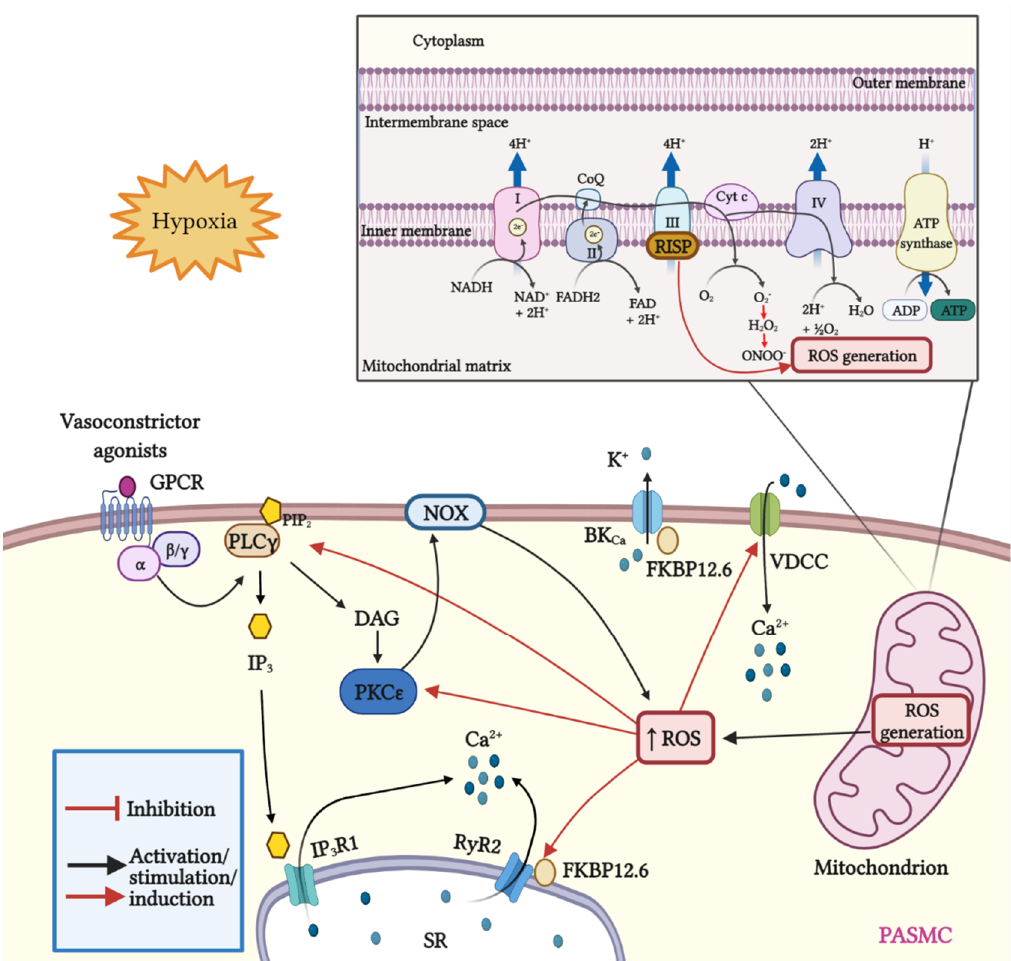
Figure 1. Schematic representation of mitROS generation and signaling; crosstalk between ROS and Ca 2+ signaling in PASMCs. Mitochondria are the major source of ROS in pulmonary artery smooth muscle cells (PASMCs). During ATP synthesis in the electron transport chain (ETC), coupling between the proton gradient on either side of the inner mitochondrial membrane leads to the production of ROS. Briefly, electrons are transferred from nicotinamide adenine dinucleotide (NADH) and flavin adenine dinucleotide (FADH2) to molecular oxygen. In this process, protons are pumped from the mitochondrial matrix into the intermembrane space, and oxygen is reduced to H 2 O. Hypoxia increases the production of mitROS, contributing to the increase in [Ca 2+ ] i and to hypoxia-induced pulmonary vasoconstriction. The Rieske iron–sulfur protein (RISP), a catalytic subunit of the complex III of the mitochondrial ETC serves as a primary molecule in intracellular ROS generation in PASMCs, especially under hypoxic conditions. In addition, mitROS and vasoconstrictor agonists stimulate the PLC γ and PKC ε signaling pathways via GPCR activation. PLC γ induces the formation of IP 3 and DAG, causing the opening of IP 3 R1 and the release of Ca 2+ from the sarcoplasmic reticulum (SR). Moreover, mitROS augment the activity of PKC ε , which in turn stimulates NOX and promotes the formation of ROS in a process named ROS-induced ROS generation (RIRG). In addition, ROS enable the dissociation of FK506 binding protein 12.6 (FKBP12.6) from ryanodine receptor 2 (RyR2) favoring the opening of this channel and enhancing Ca 2+ release. Furthermore, FKBP12.6 is physically bound to high conductance K + channels (BK Ca ) and regulates their open probability. Finally, ROS upregulate voltage-dependent Ca 2+ channels (VDCCs) which further contribute to the increase in [Ca 2+ ] i , leading to persistent vasoconstriction observed in